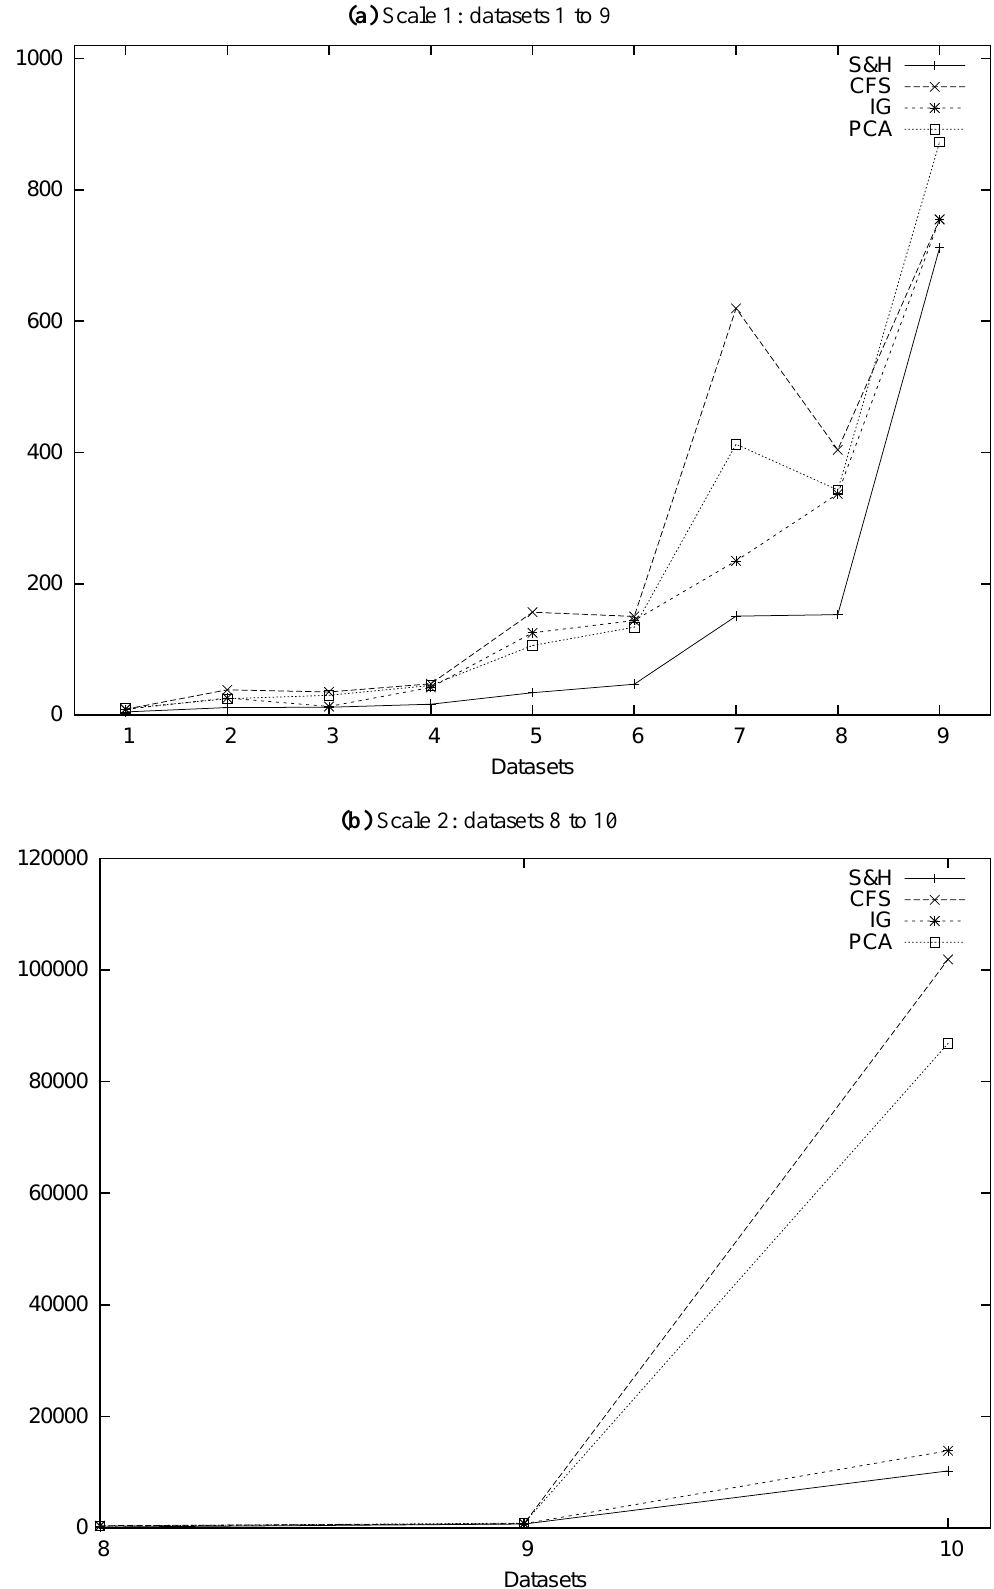
(b) Scale 2: datasets 8 to